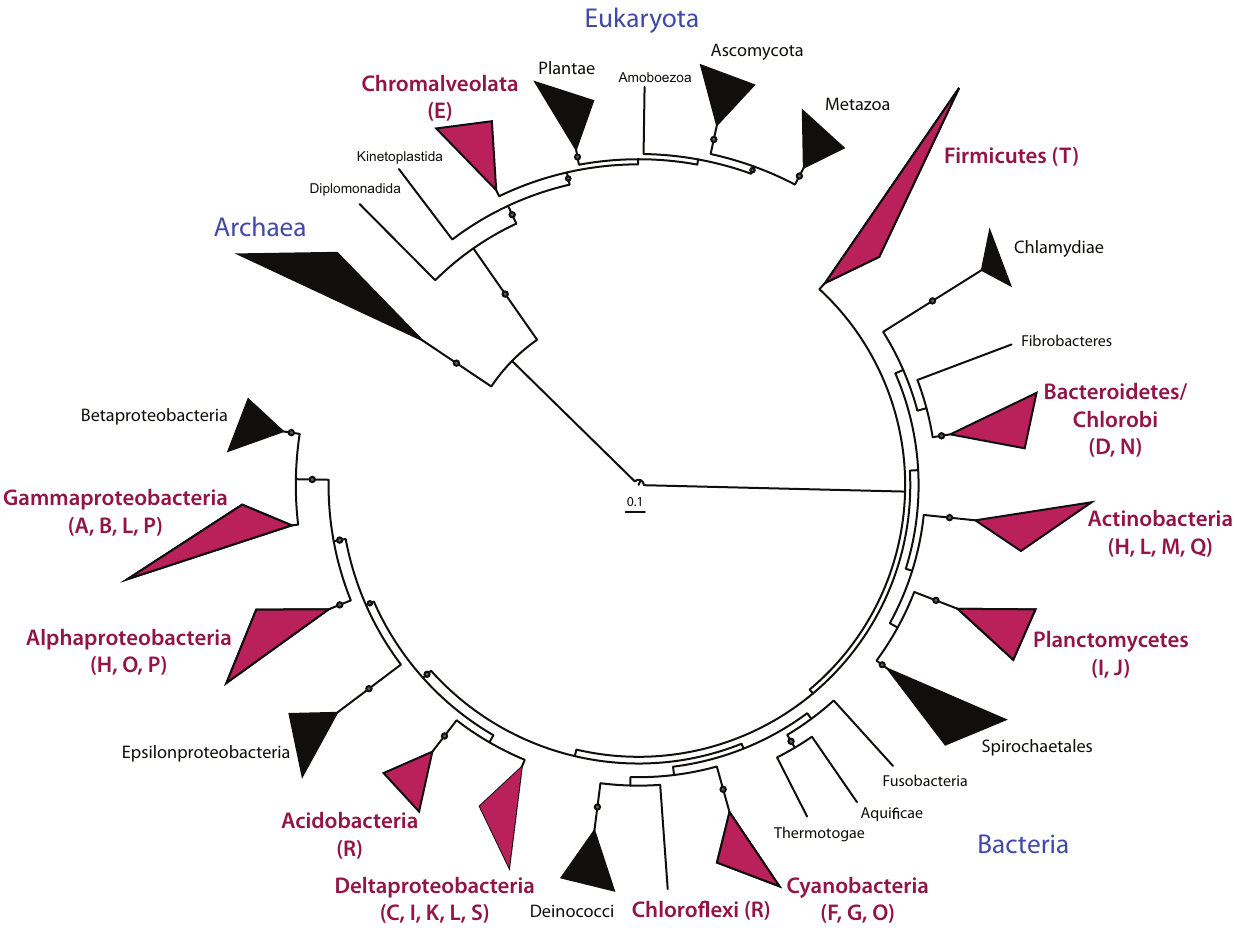
Figure 3. Phylogenetic distribution of pfa gene clusters and homologues. Clades in red contain putative secondary lipid gene clusters. Tree modified from the Interactive Tree of Life.